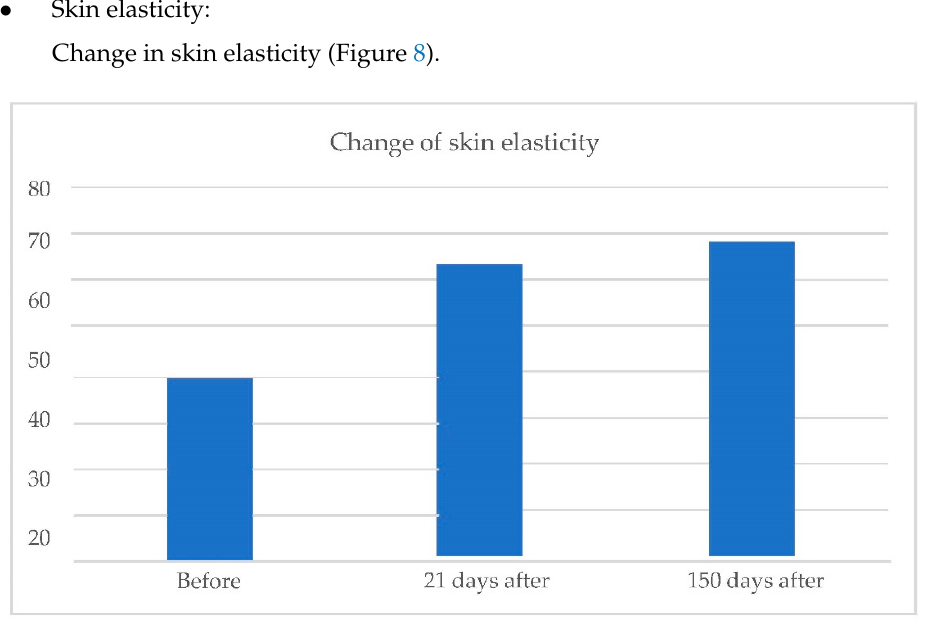
Figure 8. From left to right change in skin elasticity before treatment; 21 days after treatment; 150 days after treatment.